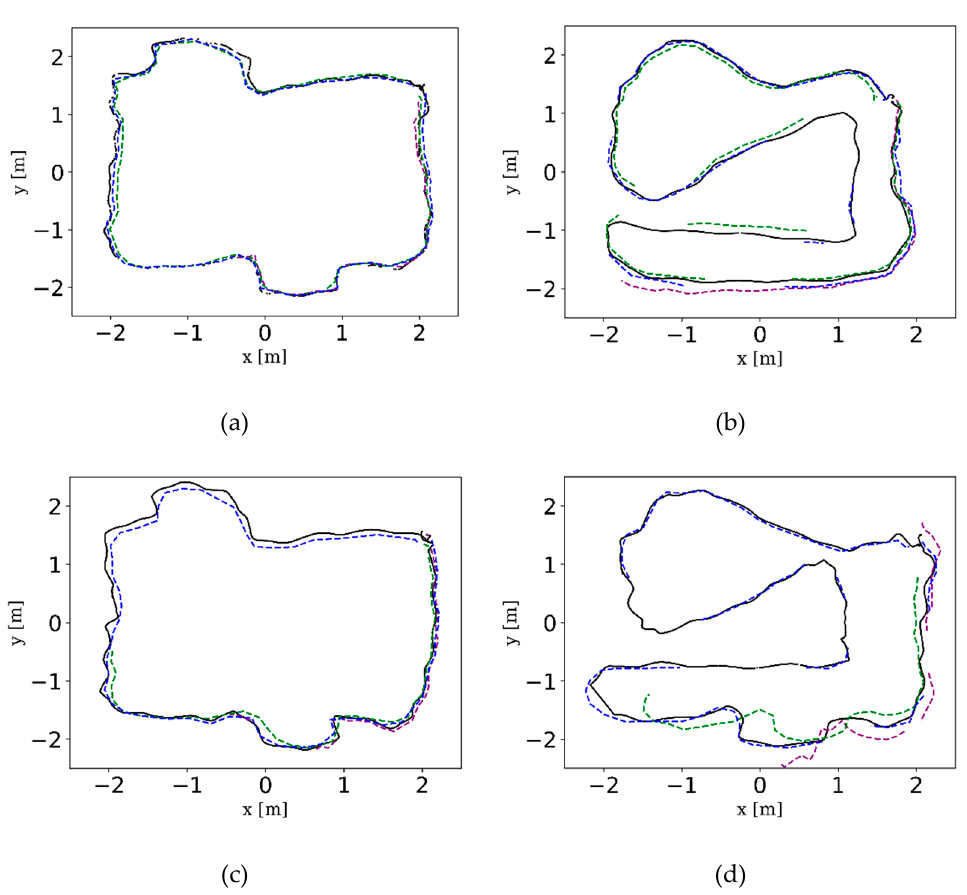
Figure 14. The comparison trajectories of VO-Mono (Purple dotted line), VO-Stereo (Green dotted line), VO-MKF (Blue dotted line), and the ground truth (Black solid line) as provided by Optitrack tracking system on different datasets. ( a ) static_squ; ( b ) static_arb; ( c ) dyn_1_squ; ( d ) dyn_1_arb. It should